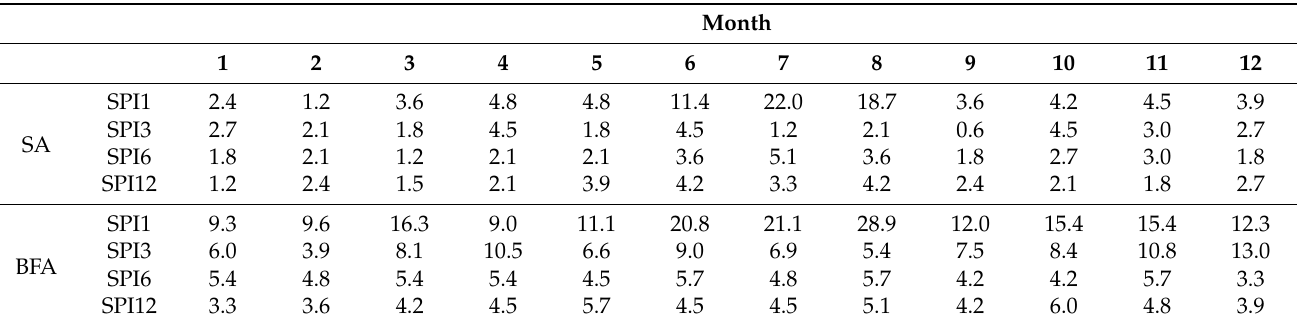
Table 6. Percentage of non-normal SPI series detected by the Shapiro-Wilk test for both the approaches and for each k − th time scale and each